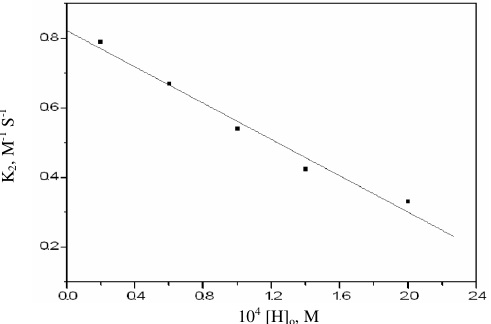
Figure 2. Effect of [H + ] in the oxidation of PTAA with NBP